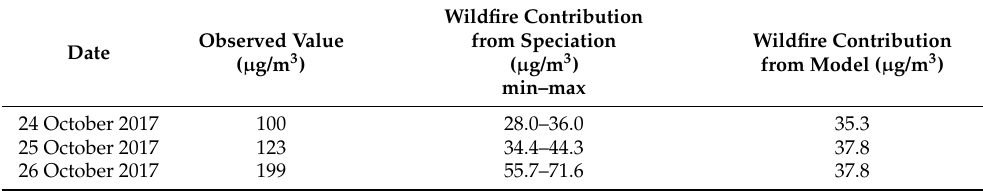
Table 6. Val di Susa wildfire event in IT0470A station: comparison between estimated wildfire PM 10 contri- bution from model and wildfire contribution from speciation, in relation to PM 10 measured